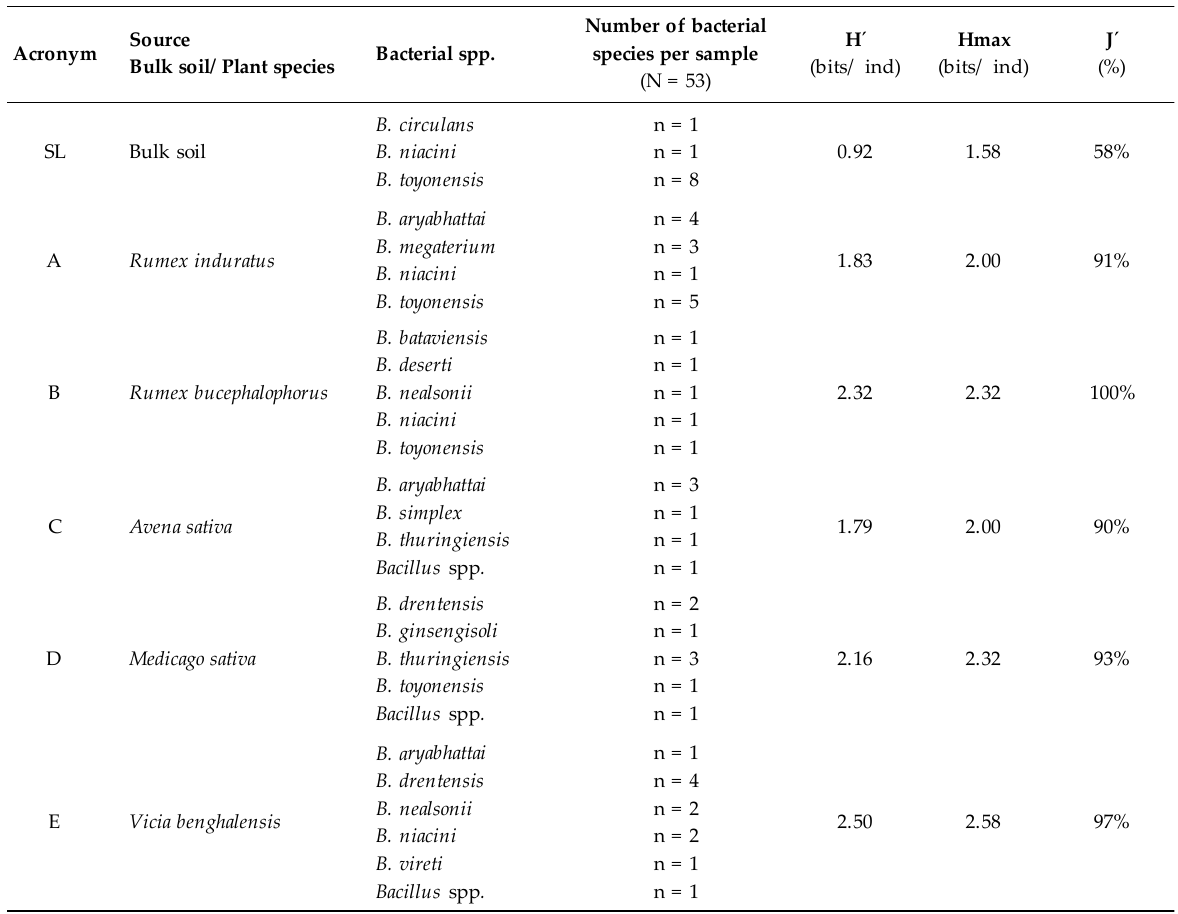
Figure 1. Isolated Bacillus spp. strains and diversity of the analyzed samples. H´: diversity calculated using the Shannon– Wiener index (bits/ind), H max : maximum diversity (bits/ind), and J´: Pielou index (%).